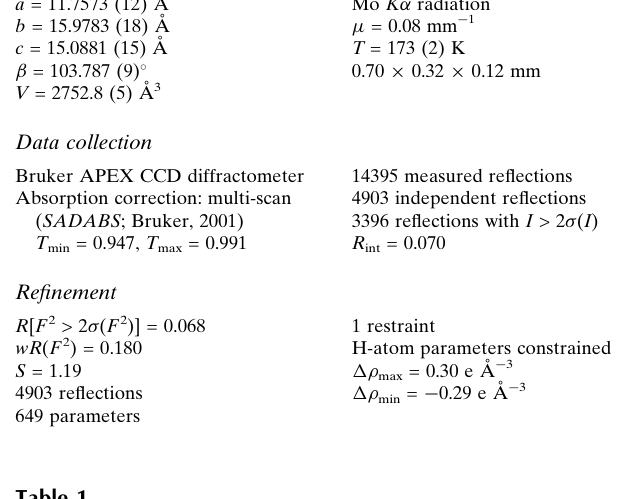
Hydrogen-bond geometry (A˚ , (cid:1) ). D —H (cid:2)(cid:2)(cid:2)